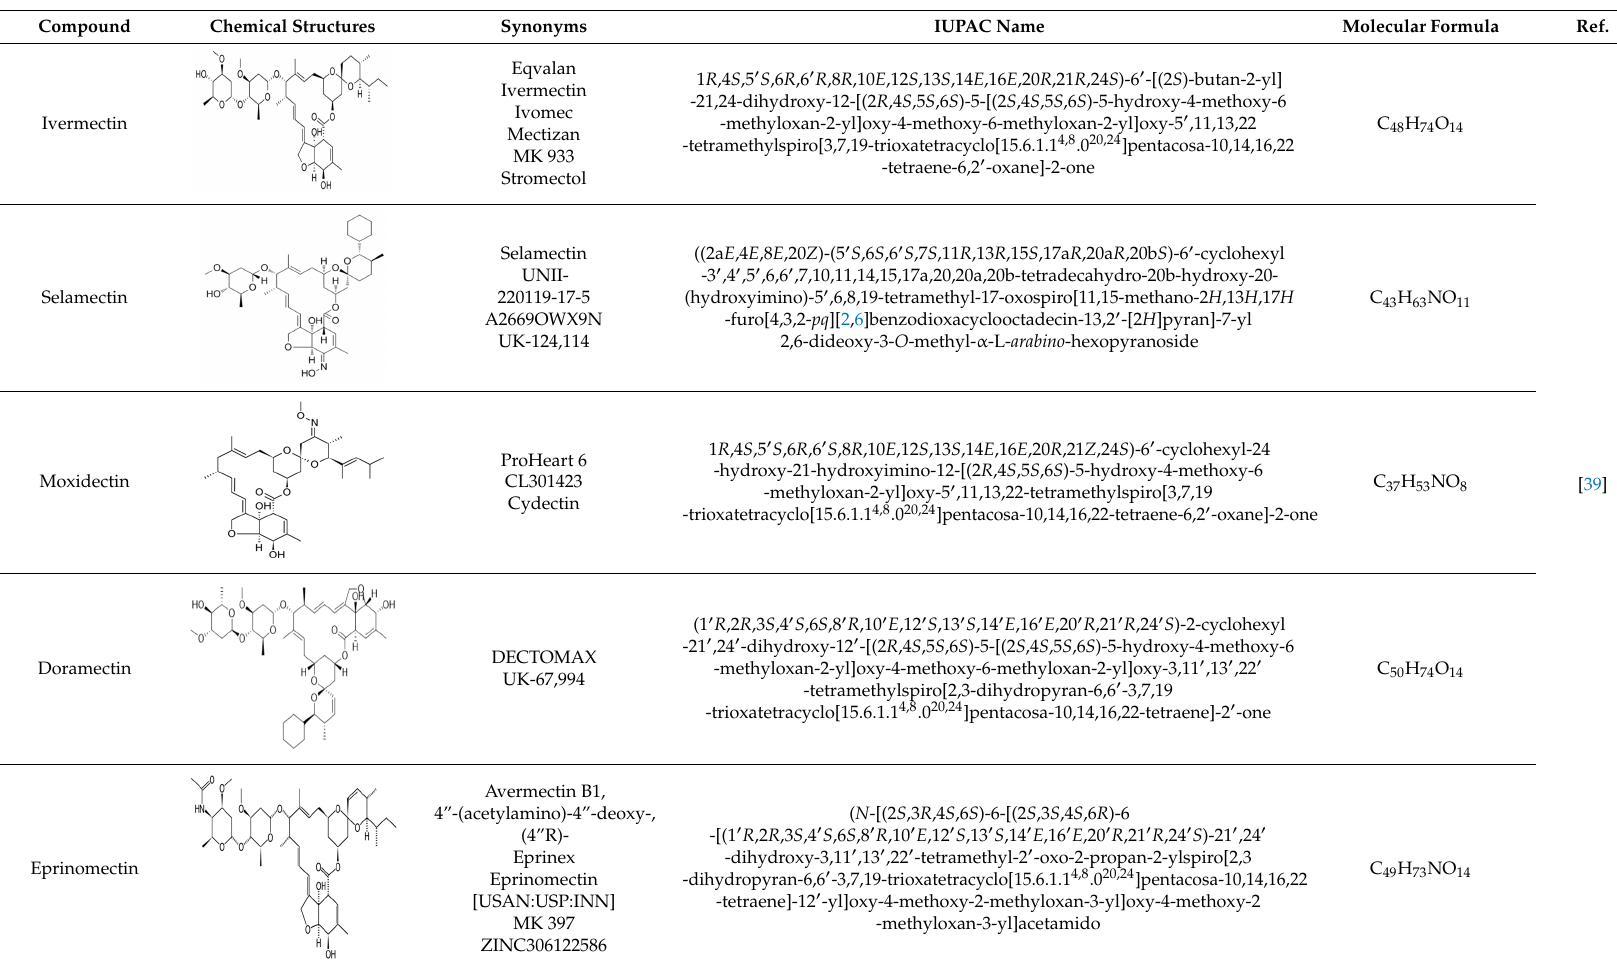
Table 1. The chemical structures, synonyms, IUPAC name, and molecular formula of ivermectin, selamectin, moxidectin, eprinomectin, nemadectin, abamectin, milbemycin and doramectin.